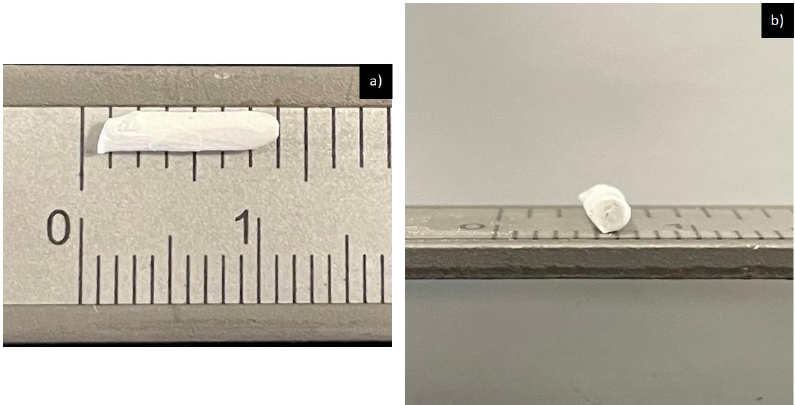
Figure 1. PCL implant before being implanted in the animal: ( a ) implant observed along; ( b ) implant observed from its internal